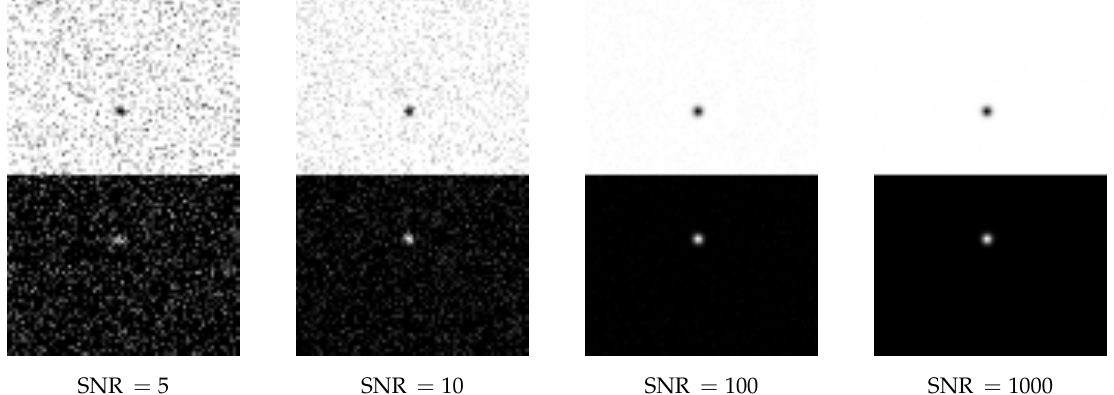
Figure 7. For 4 different signal to noise ratios example images are given, which were used in Figure 5. Each example shows 2 particles—one in the upper and and one in the lower half. The lower halves of the figures show the original images, while the upper halves are shown in inverted colors for better